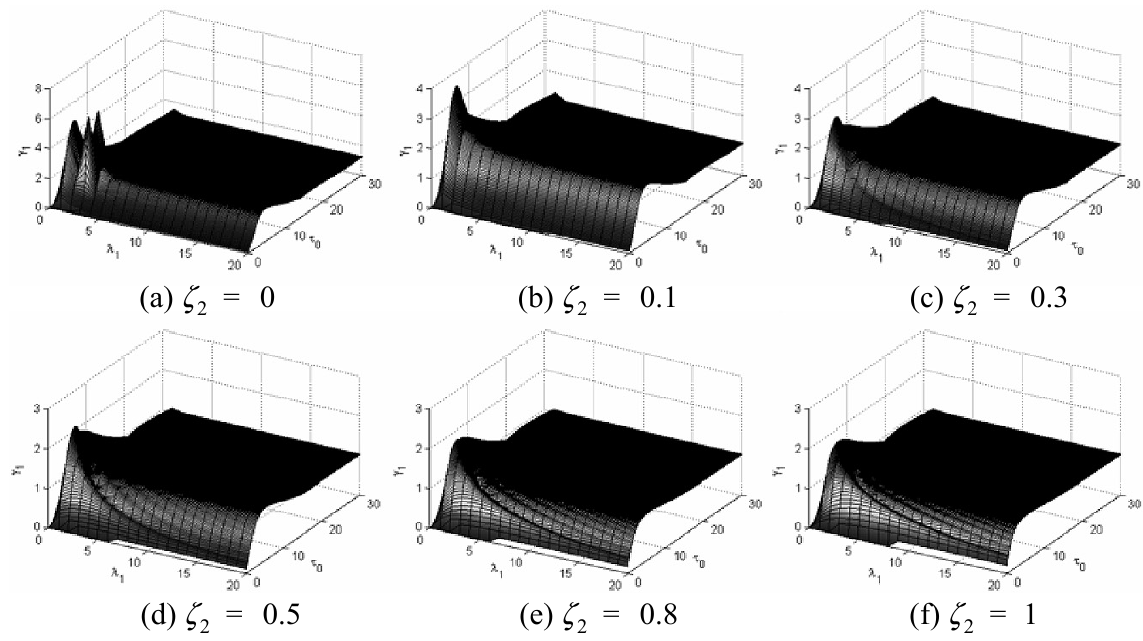
(cid:1)(cid:1) = 0 . 5 , λ 2 = 0 . 1 , 0 m